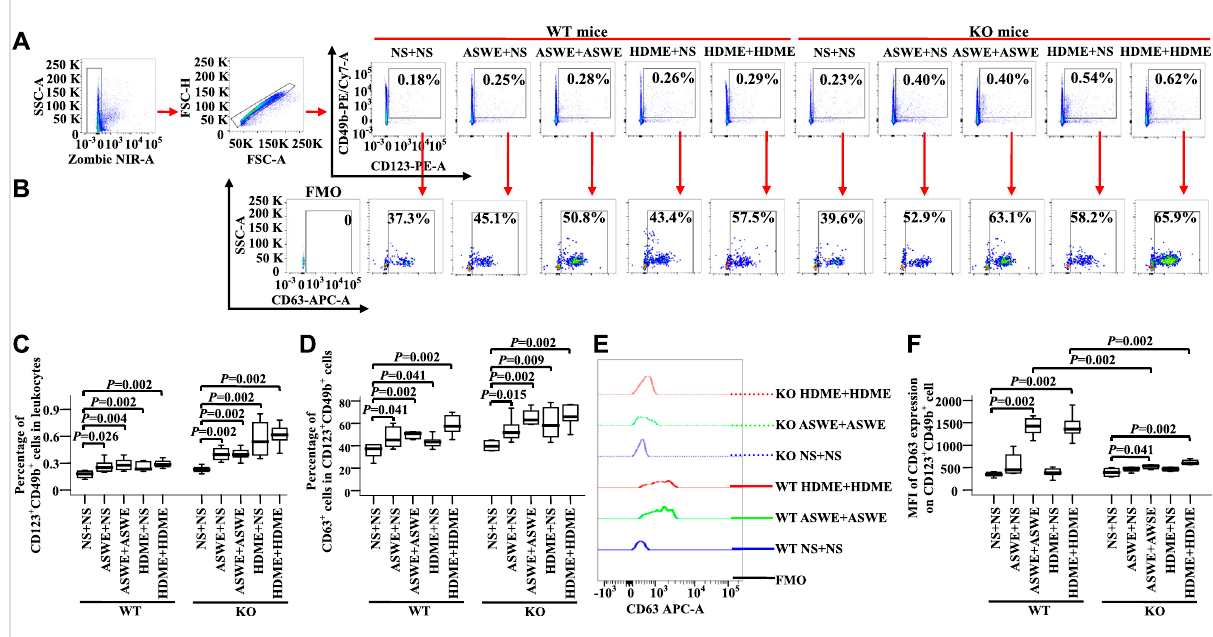
FIGURE 8 Expression ofCD63 inbloodbasophils ofwild-type(WT) andFc ε RI α knockout(KO)mice. (A) and (B) gatingstrategiesandrepresentative fi gures of CD49b + CD123+basophils in leukocytes and the expression of CD63 in basophils. (C) percentages of CD49b + CD123+ basophils in leukocytes. (D) percentagesofCD63+cellsinCD49b +CD123+basophils. (E) representativegraphofMFIofCD63expressioninCD49b+CD123+basophiland (F) MFI of CD63 expression in CD49b +CD123+basophil. Data were displayed as boxplots for ASWE-sensitized and ASWE-challenged (ASWE + ASWE), ASWE-sensitized and normal saline challenged (ASWE + NS), HDME-sensitized and HDME-challenged (HDME + HDME), HDME-sensitized and normal saline challenged (HDME + NS), and NS control mice (NS + NS), which indicated the median, interquartile range, and the largest and smallest values for the number of experiments indicated. A total of seven animals were in each group. FMO = fl uorescence minus one control. * p < 0.05 was taken as statistically signi fi